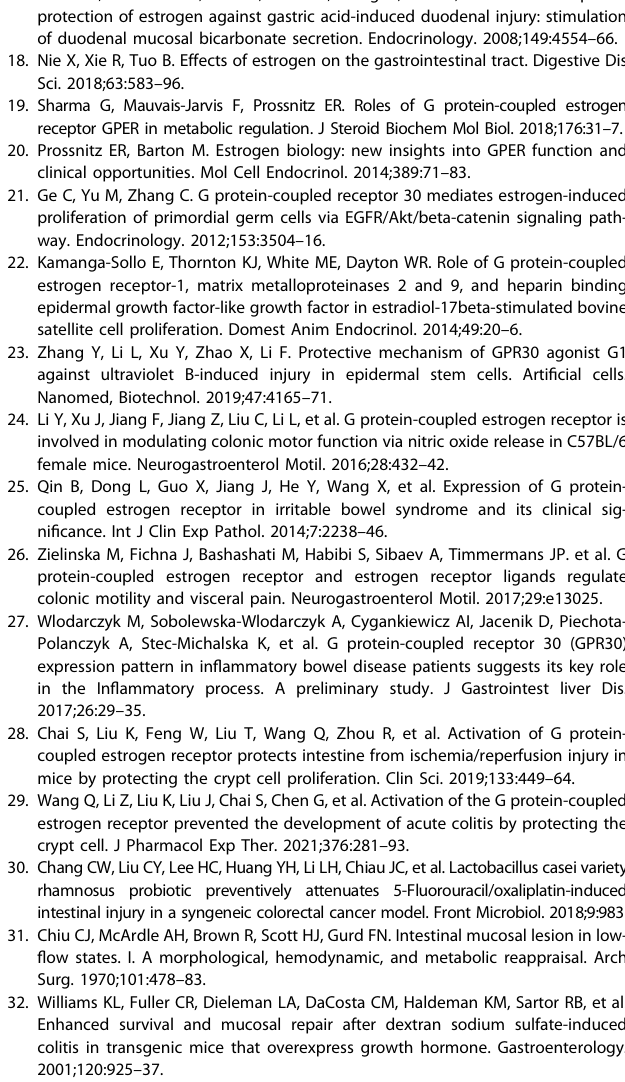
Fig. 8 The role of regulating ERK1/2 activity in GPER activation protecting 5-FU induced CIM. CIM model was induced by i.p. injection 5-FU (30 mg/kg/day) from day 0 to day 5. G-1 (0.03 mg/kg/day) and/or ERK1/2 inhibitor PD0325901 (5 mg/kg/day) were administrated intraperitoneally together with 5-FU. On the 5 th day, the ileum was collected for H& E staining, immuno fl uorescence staining, immunohistochemical staining and western blot. Data were expressed as mean ± SEM (* P < 0.05, ** P < 0.01, *** P < 0.001). a Representative immunohistochemical images of γ H2AX staining in the ileum of the CIM model following G-1 administration or in combination with PD0325901 (Scale bars: 20 μ m). b Statistical graph of γ H2AX + cells in ileal crypt within three subgroups to show the role of regulating ERK1/2 activity in GPER inhibiting DNA damage induced by CIM. 15 crypts were randomly calculated in each section, and the average value was obtained ( n = 5). c Effect of ERK1/2 inhibitor PD0325901 on G-1 in reducing intestinal mucosal damage score and crypt damage score of CIM model ( n = 9). d Effect of ERK1/2 inhibitor PD0325901 on G-1 inhibition of crypt depth reduction and villus shortening in the CIM model ( n = 9). At least 20 villi were counted randomly for each sample, and the mean value was calculated for single sample. e Effect of ERK1/2 inhibitor PD0325901 on G-1 inhibition of weight loss in the CIM model ( n = 9). f Effect of ERK1/2 inhibitor PD0325901on G-1 protected ileal mucosal permeability in the CIM model ( n = 6). The mucosal permeability was evaluated by the concentration of Fluorescein isothiocyanate (FITC) -dextran in blood. g Representative immunohistochemical images of BrdU staining within four subgroups (scale bars: 20 μ m) and statistical graph of BrdU + cell to show the effect of ERK1/2 inhibitor PD0325901 on G-1 protecting proliferation of crypt cells in the CIM model. At least 20 crypts were counted randomly, and the mean value was calculated for single sample ( n = 6). h Representative immunohistochemical images of Ki67 staining within four subgroups (scale bars: 20 μ m) and statistical graph of Ki67 + cell to show the effect of ERK1/2 inhibitor PD0325901 on G-1 protecting proliferation of crypt cells in the CIM model. At least 20 crypts were counted randomly, and the mean value was calculated for single sample ( n = 6). i Representative images of TUNEL staining within four subgroups (scale bars: 50 μ m) and statistical graph of TUNEL + cell to show the effect of ERK1/2 inhibitor PD0325901 on G-1 inhibiting apoptosis of crypt cells in the CIM model. At least 20 crypts were counted randomly, and the mean value was calculated for single sample ( n = 6). j Representative immunohistochemical images of Muc-2 staining within four subgroups (scale bars: 50 μ m) and statistical graph of Muc-2 + cells to show the effect of ERK1/2 inhibitor PD0325901 on G-1 protecting the mucus barrier in the CIM model. At least 20 villi were counted randomly, and the mean value was calculated for single sample ( n =